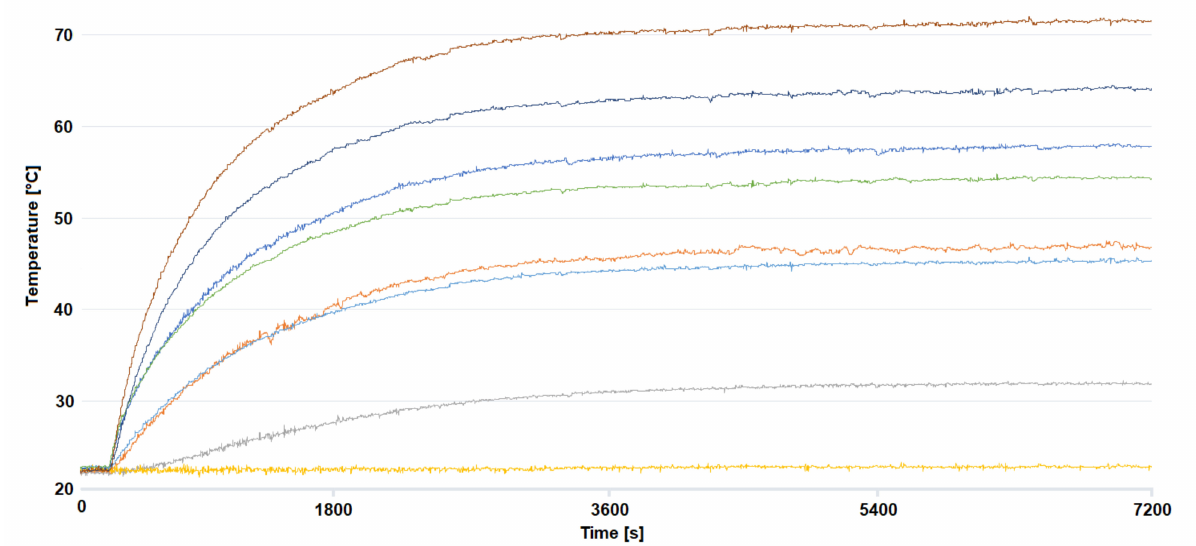
Figure 6. Chart showing results for thermocouples T1; T2; T3; T4; T5 and T6. The results were obtained for a time of 7200 s for a type of fuse NH000 gG 100 A and for a current of 120 A.